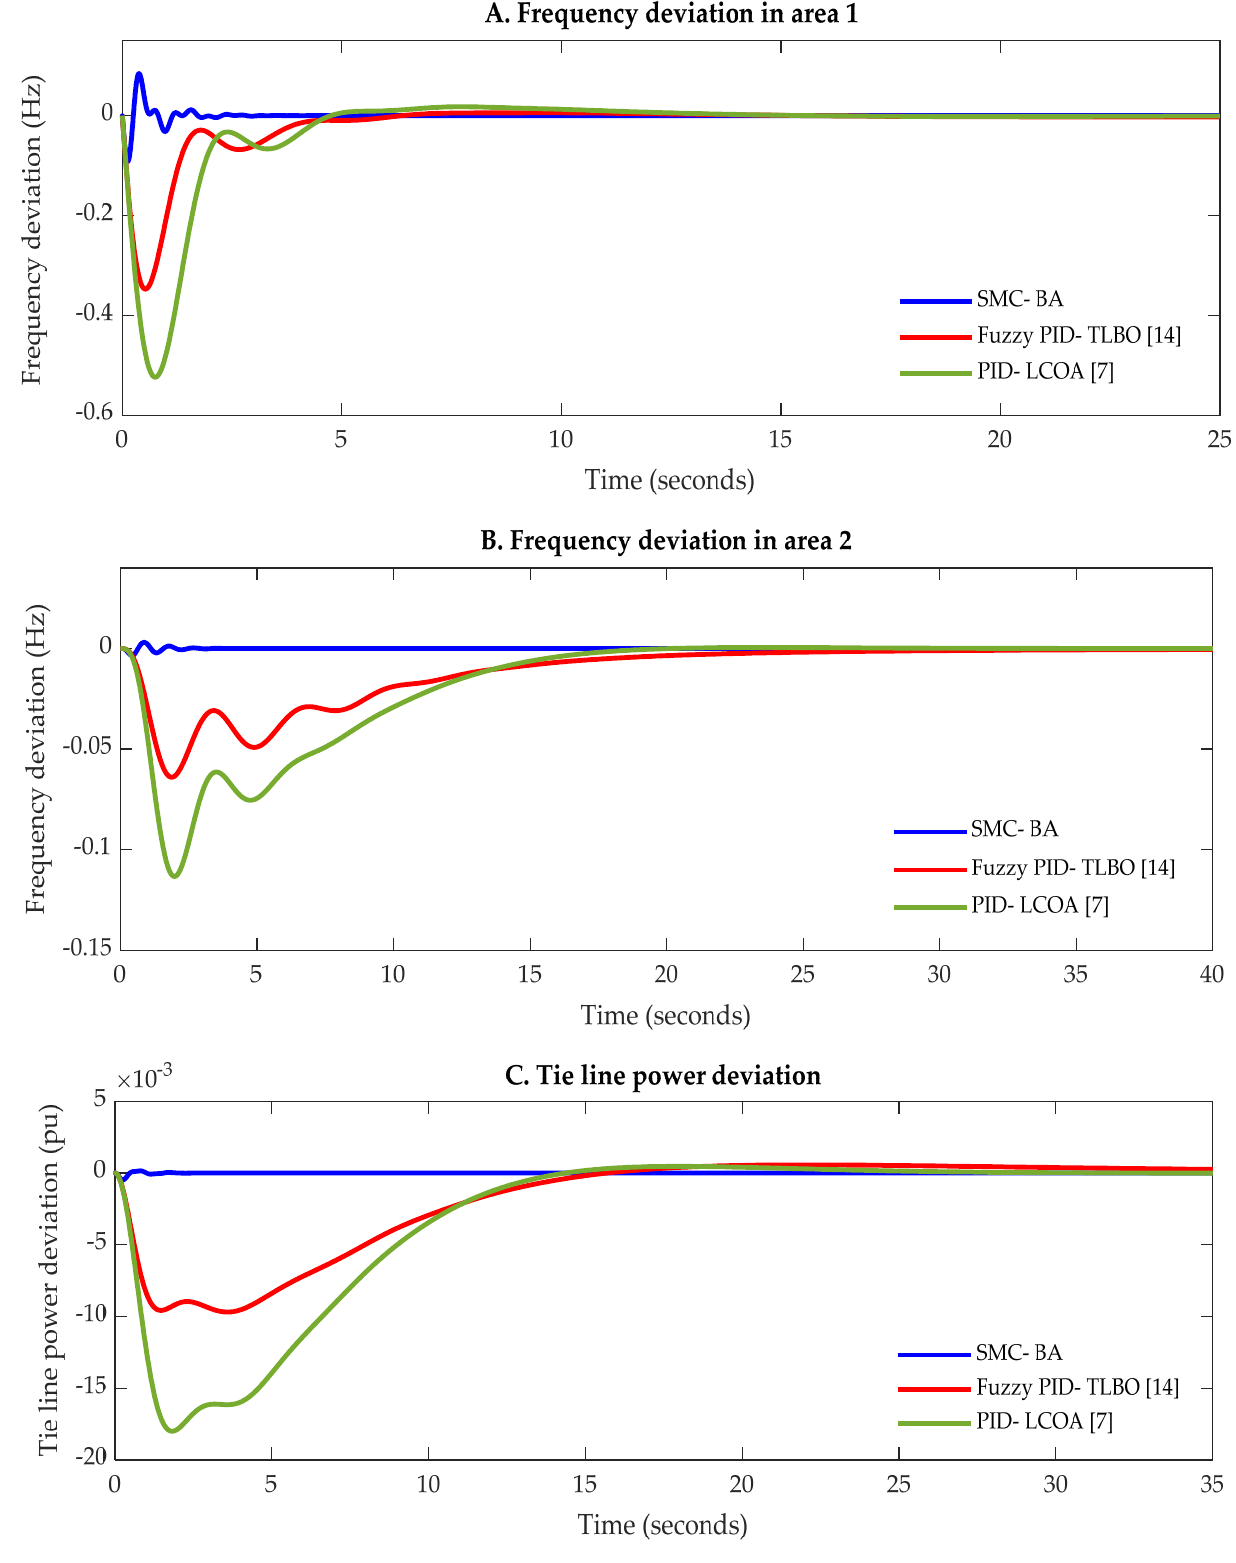
Figure 9. Dynamic response of the system with different controllers under parametric uncertainties, case 3. ( A ) Frequency deviation in area 1; ( B ) Frequency deviation in area 2; ( C ) Tie line power deviation.